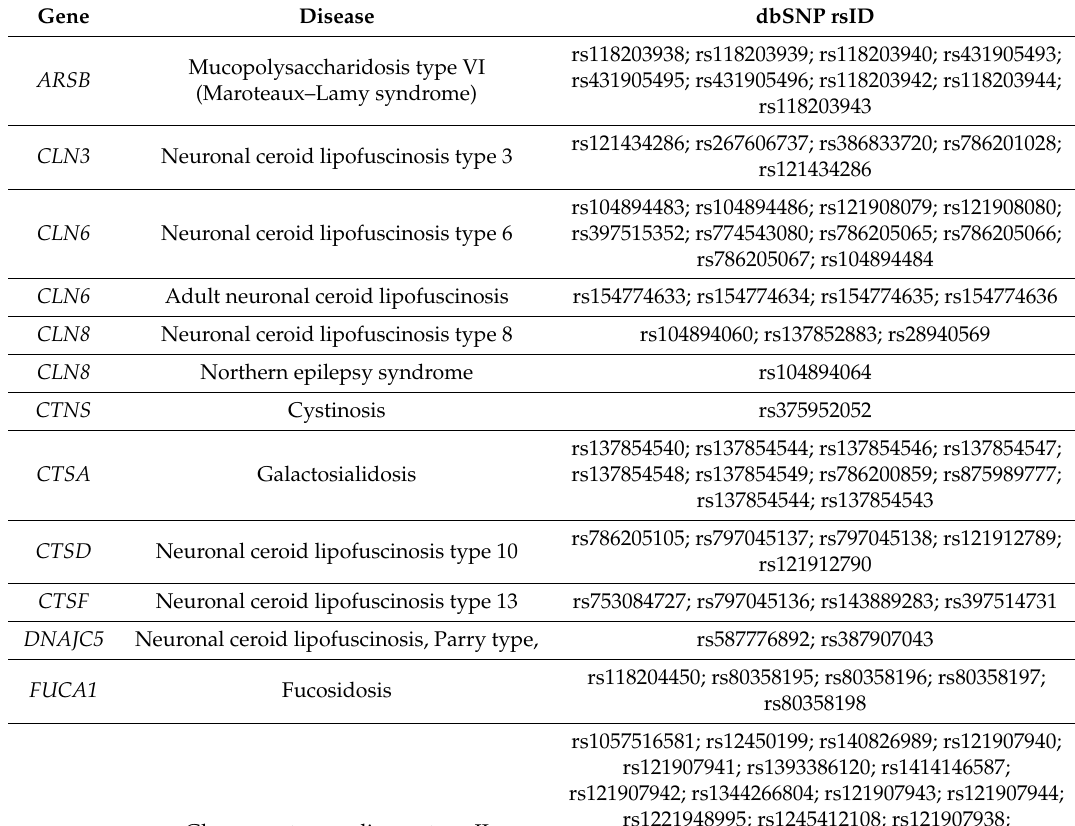
Table 7. Clinically relevant SNPs in lysosomal